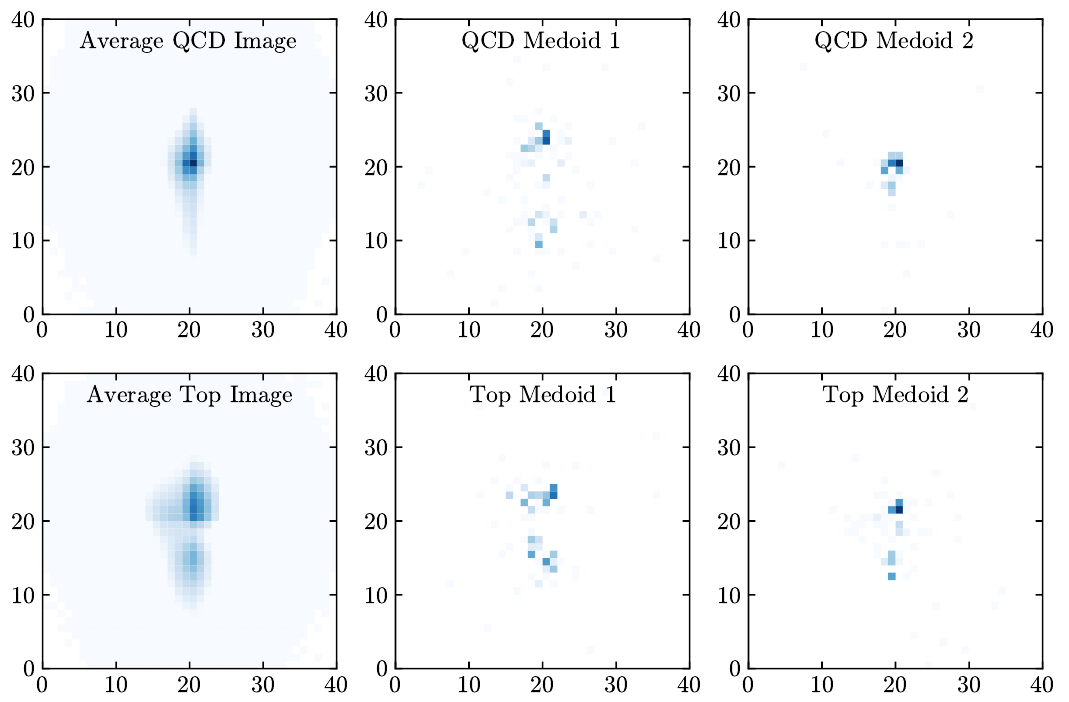
Figure 8 . Images of example QCD and top events. The top row shows QCD events; the bottom row shows top events. The left column shows the average image in each case, and the other two columns show two medoids computed with the 1-Wasserstein metric. Note medoids are more sparse and varied than average images, and that one of the top medoids appears “QCD-like” when we include multiple